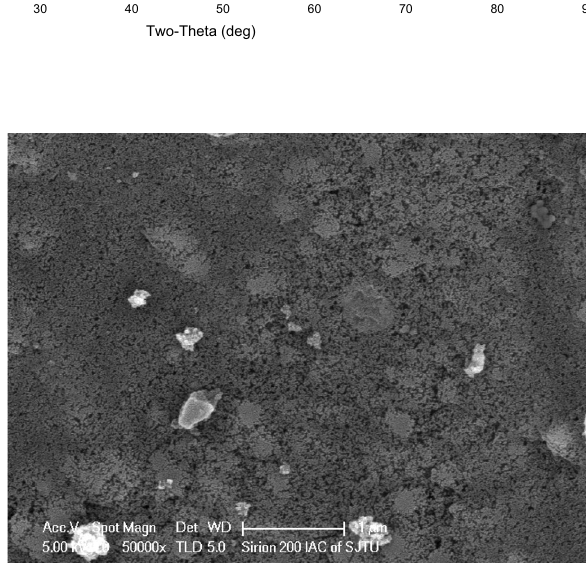
Fig. 6 Field emission scanning electron microscopy of the banana trunk-activated carbon (run number